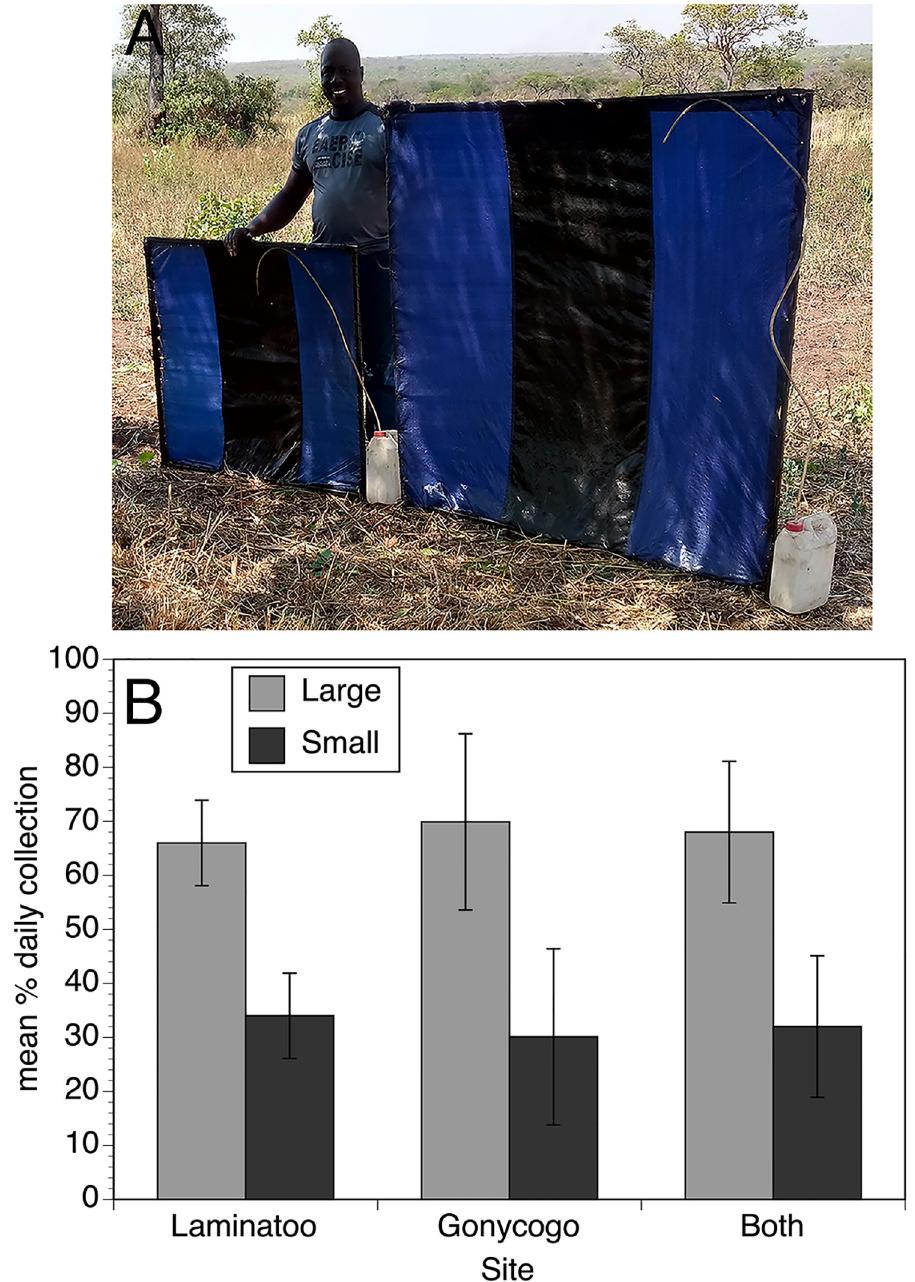
Fig 2. Relative performance of 1.5m and 1m square trap designs. Panel A: Photograph of the 1m and 1.5m trap designs. Panel B: Bars represent the relative performance of the 1m and 1.5m trap designs in Laminatoo, Gonycogo and data from both communities combined. Data are presented as the mean percentage of the total collection by day, normalizing for variations in the absolute number of flies collected on each day, as described in Materials and Methods. Error bars indicate the standard deviation associated with the means. The analysis from Laminatoo incorporated data collected from 18 paired trials, while the analysis from Gonycogo included 20 paired trials. Raw collection data for this study may be found in the S1